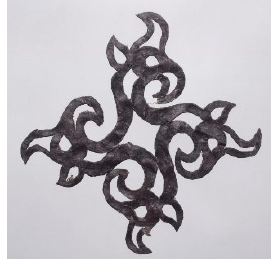
Figure 16. Applique in the form of four griffins’ heads (SHM inv. no. 2179 ‐ 903); leather; Kurgan 1,